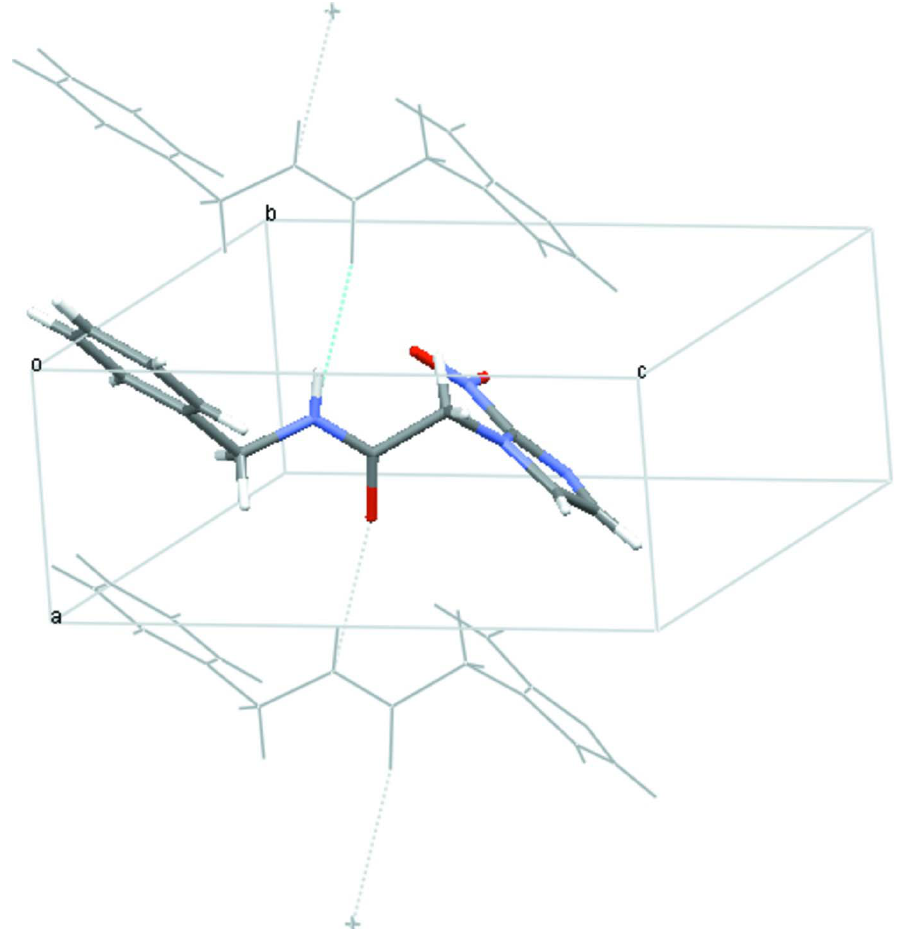
Figure 2 Hydrogen bond network along the a